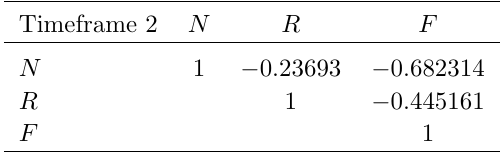
Table A.4. Spearman ρ between different variables of timeframe 2 for nuclear